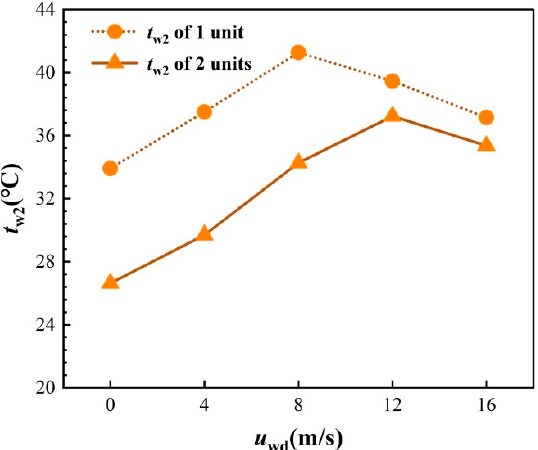
Figure 19. Air mass flow rates of NDDCS with one tower in the cases of 2 units and 1 unit under typical crosswind speeds.